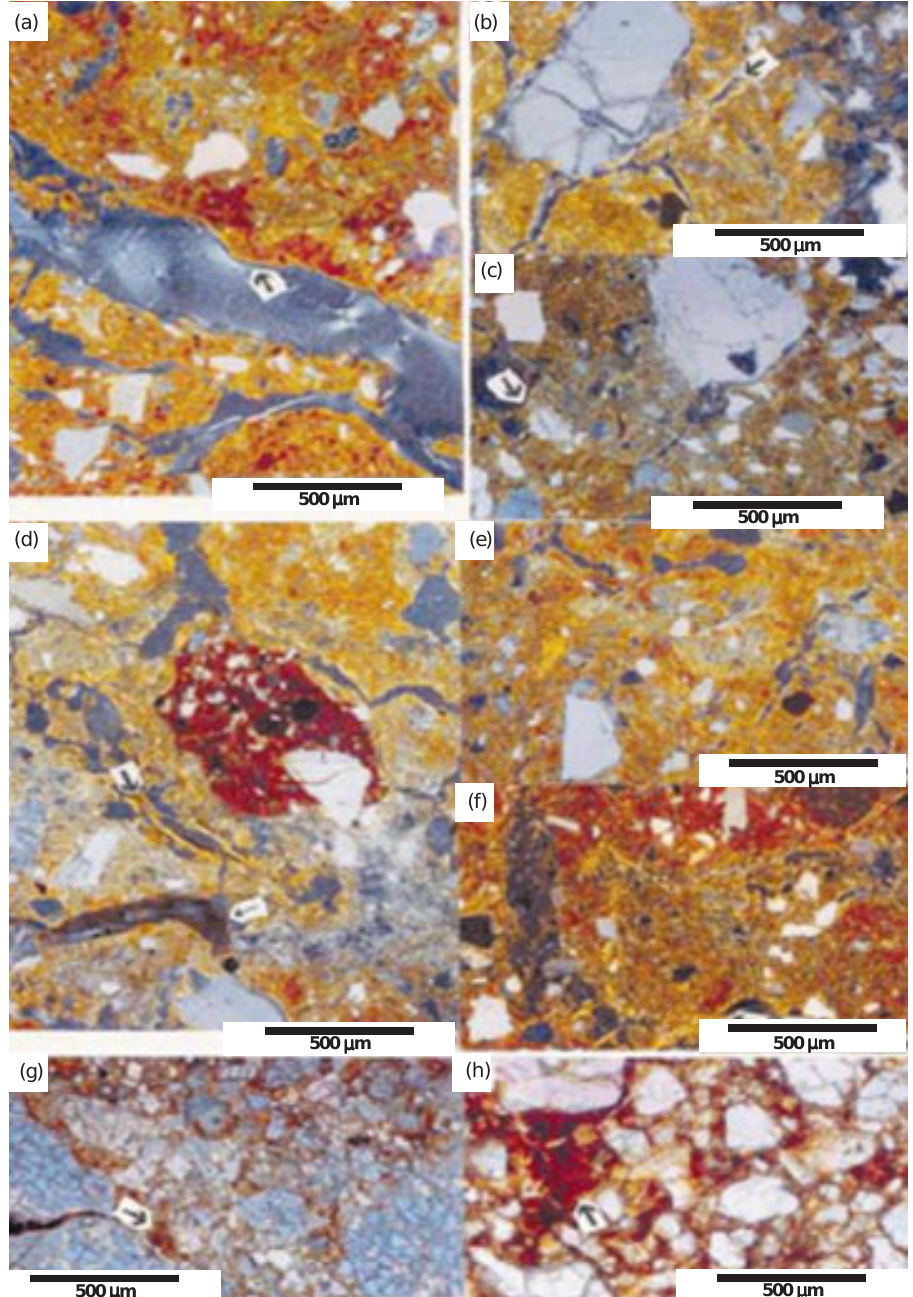
Figura 6. Fotomicrografias de alguns horizontes Bt selecionados. Setas indicam feições micropedológicas discutidas no